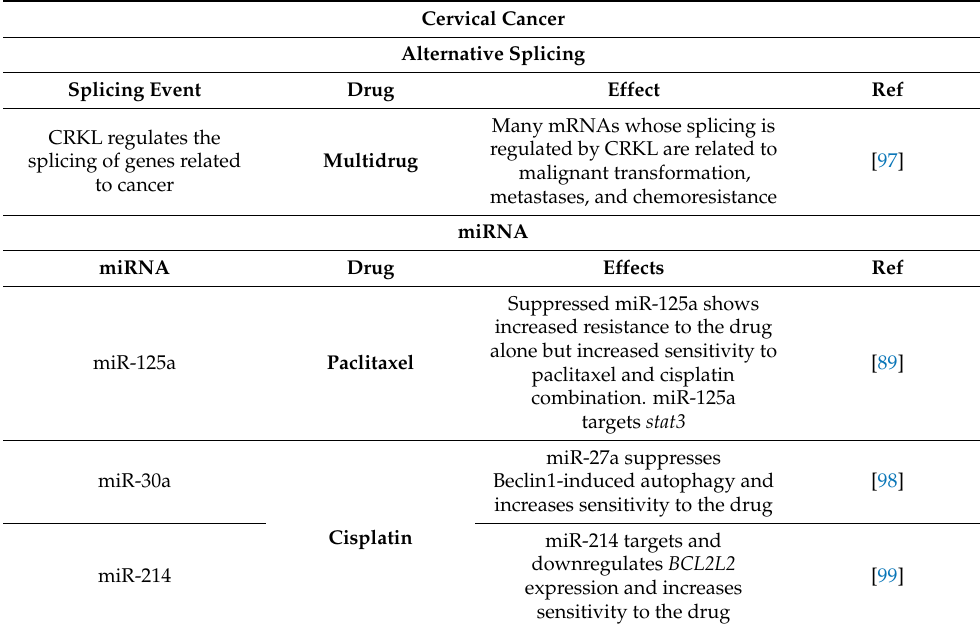
Table 2. Alternative splicing events and miRNAs involved in drug resistance in cervical cancer